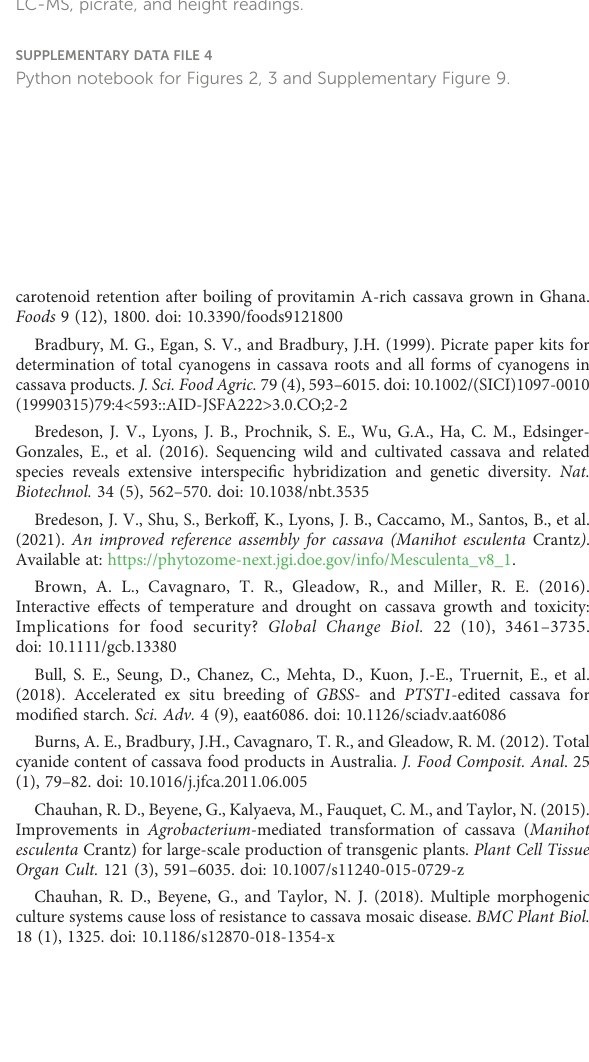
and TMS 91/02324 lines. SUPPLEMENTARY DATA FILE 3 LC-MS, picrate, and height readings. SUPPLEMENTARY DATA FILE 4 Python notebook for Figures 2, 3 and Supplementary Figure